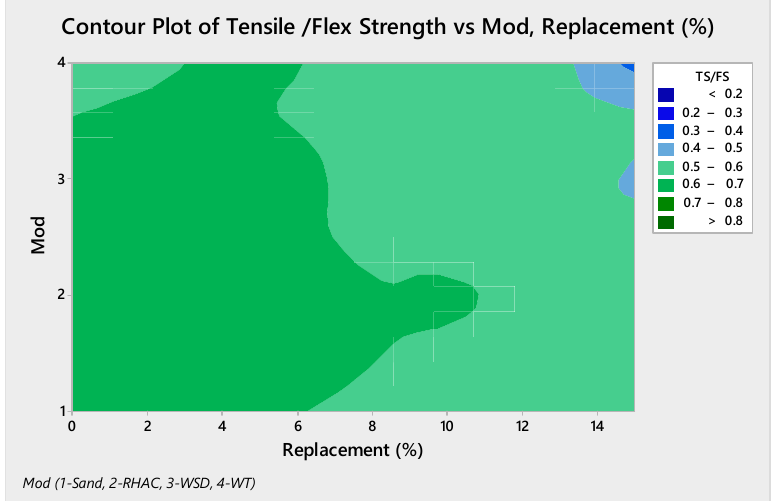
Figure 8. Contour plot of tensile/flexural strength (MPa) vs. mod, replacement (%).